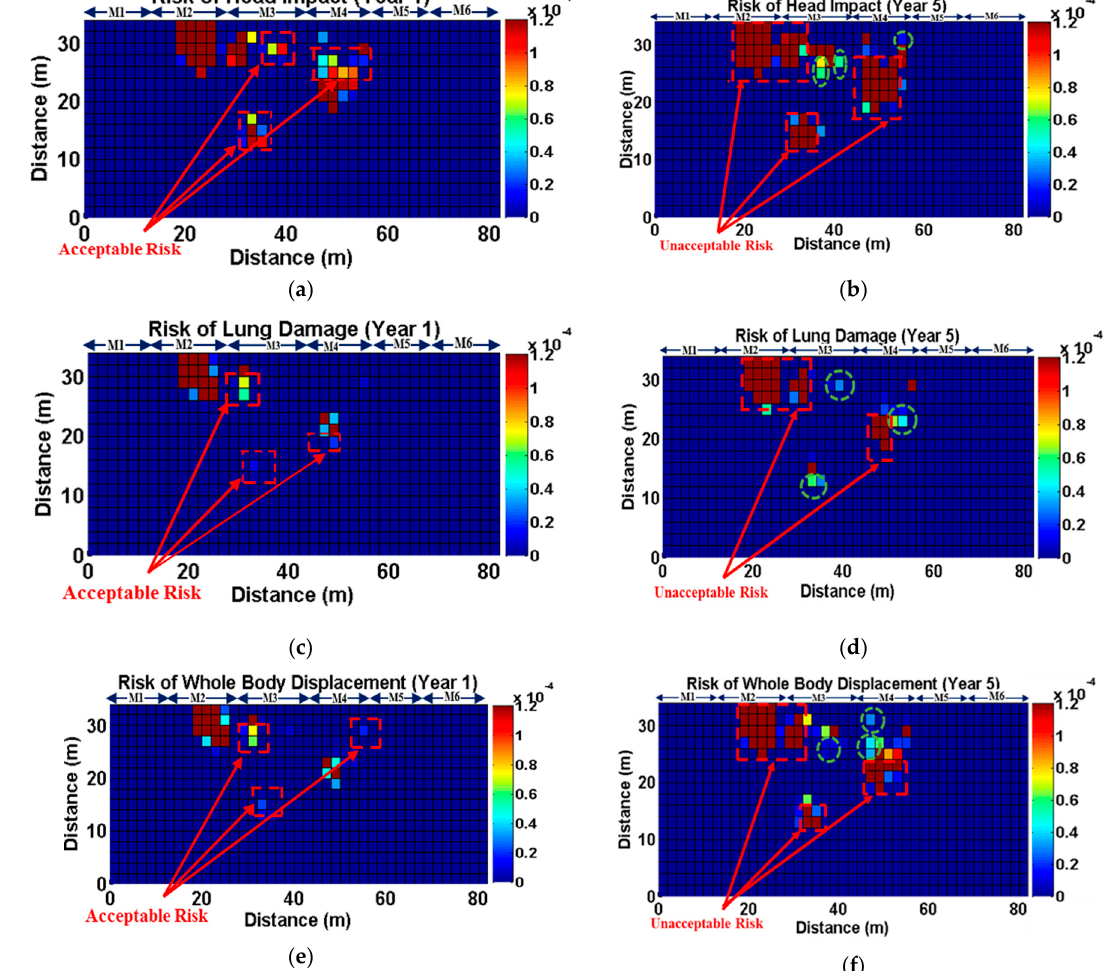
Figure 14. Dynamic risk of a human fatality at different years at 16 kg/s leak rate of 16 kg/s with 3 m/s wind speed. ( a ) Risk of head impact at year 1. ( b ) Risk of head impact at year 5. ( c ) Risk of lung damage at year 1. ( d ) Risk of lung damage at year 5. ( e ) Risk of whole-body displacement at year 1. ( f ) Risk of whole-body displacement at year 5.